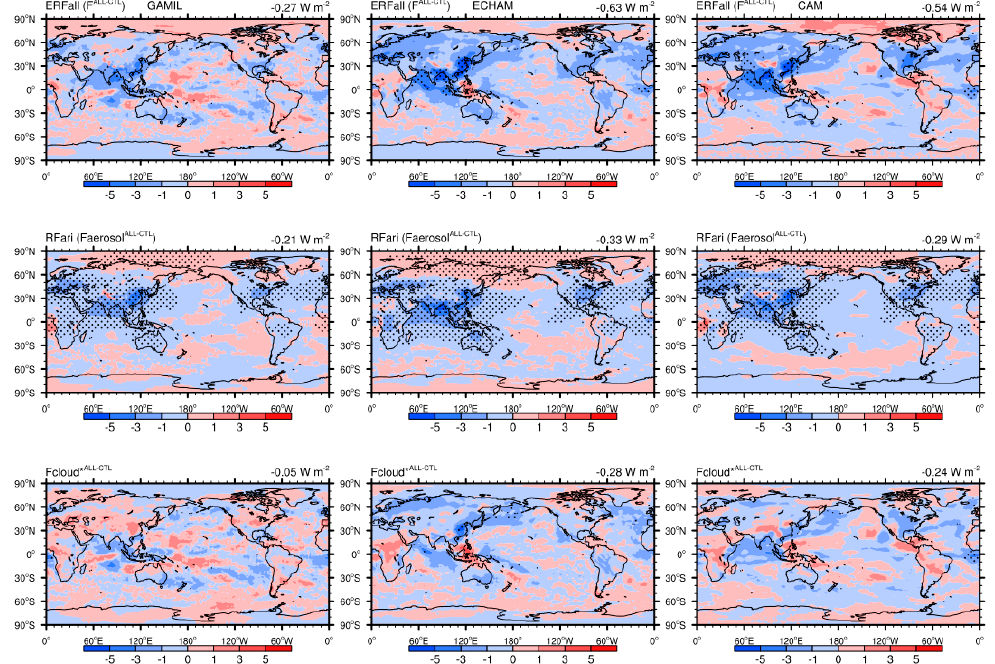
Figure 2. Multi-member ensemble means of anthropogenic aerosol effective radiative forcing (ERFall = F ALL − CTL , upper panel), instantaneous radiative forcing from aerosol–radiation interactions (RFari = Faerosol ALL − CTL , middle panel), and effects on shortwave cloud forcing (Fcloud *ALL − CTL , lower panel) with the GAMIL (left), ECHAM (middle), and CAM (right) models. The number on the top right of the figure denotes the ensemble average of global annual mean values. Differences significant at the 10% level of the Student’s t -test are depicted by dots.